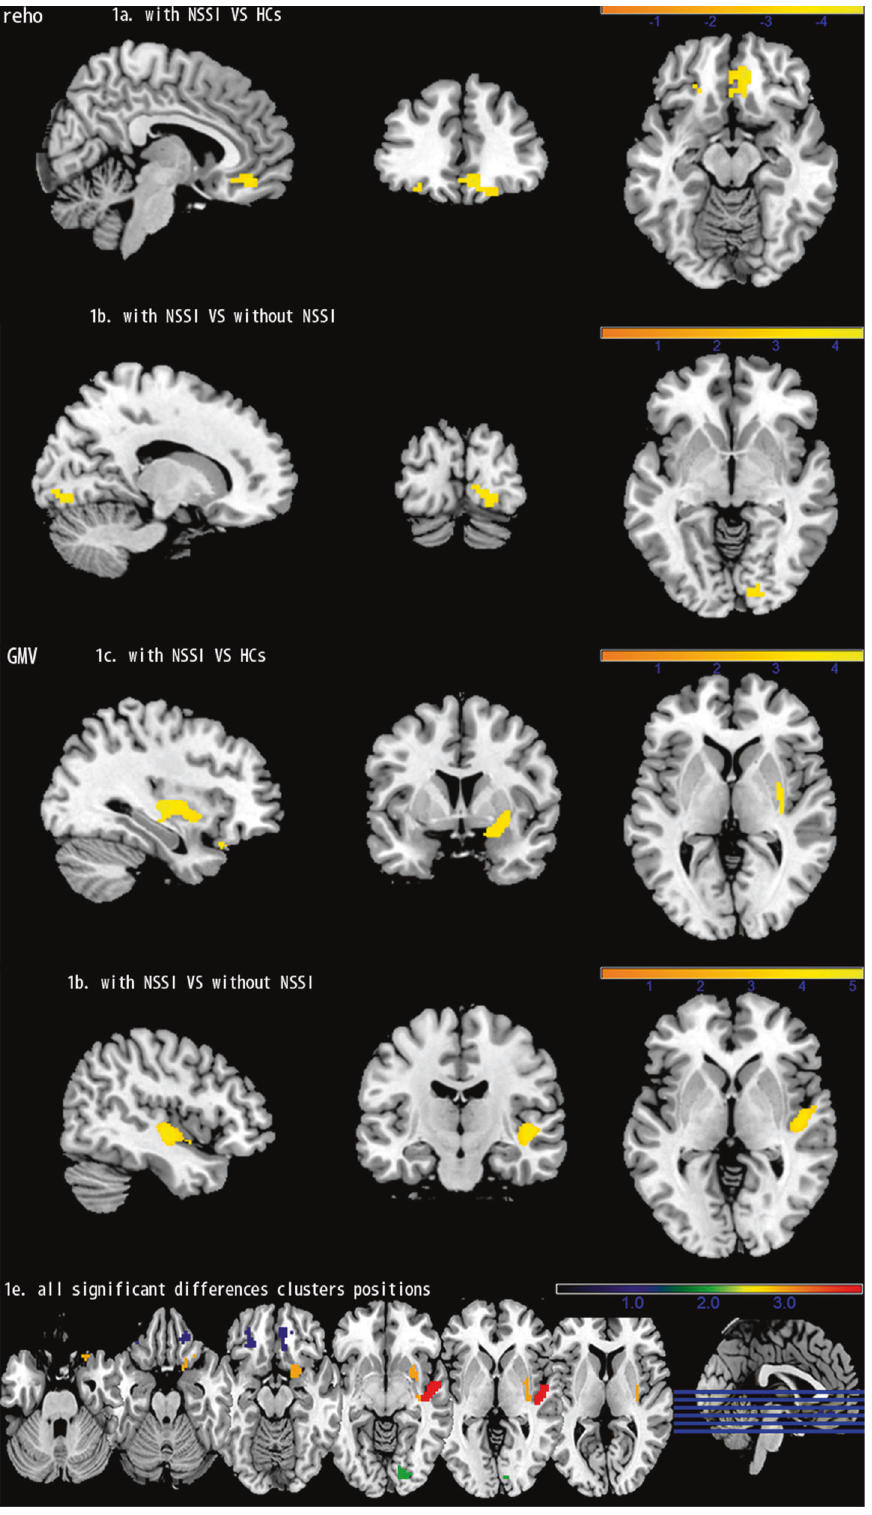
Fig. 1 Comparison GMV and ReHo of between MDD with NSSI and HCs, and MDD with and without NSSI. a , b Show the difference in Reho. c , d Show the difference in GMV. MDD major depressive disorder, NSSI nonsuicidal self-injury, HCs healthy controls, GMV grey matter volume, ReHo regional homogeneity used NSSI history as a label prediction to construct the model. Random forest model The importance ranking of the above factors in predicting We used all previously obtained neuroimaging indicators of whether MDD is accompanied by NSSI is shown in Table 2. The MDD patients without NSSI and NSSI history as predictors and